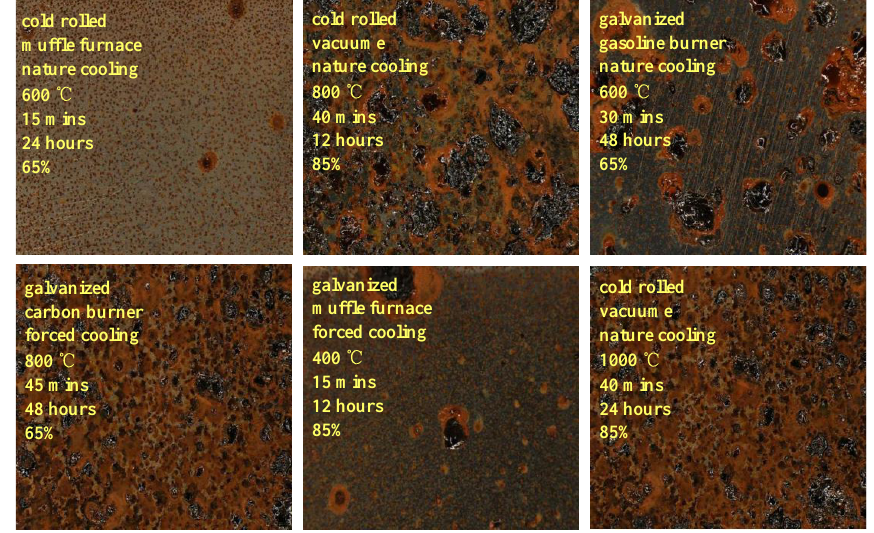
Figure 1. Demonstration of generated heated metal mark image samples. Seven attributes are labeled on the top-left position of each